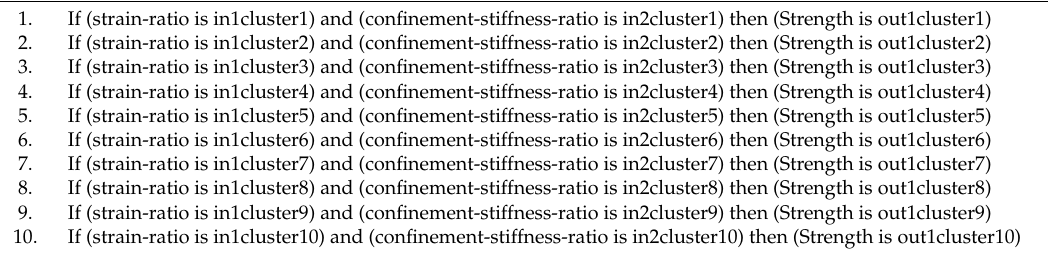
Table 3. Rule base of the optimal ANFIS-FCM in modeling strength.